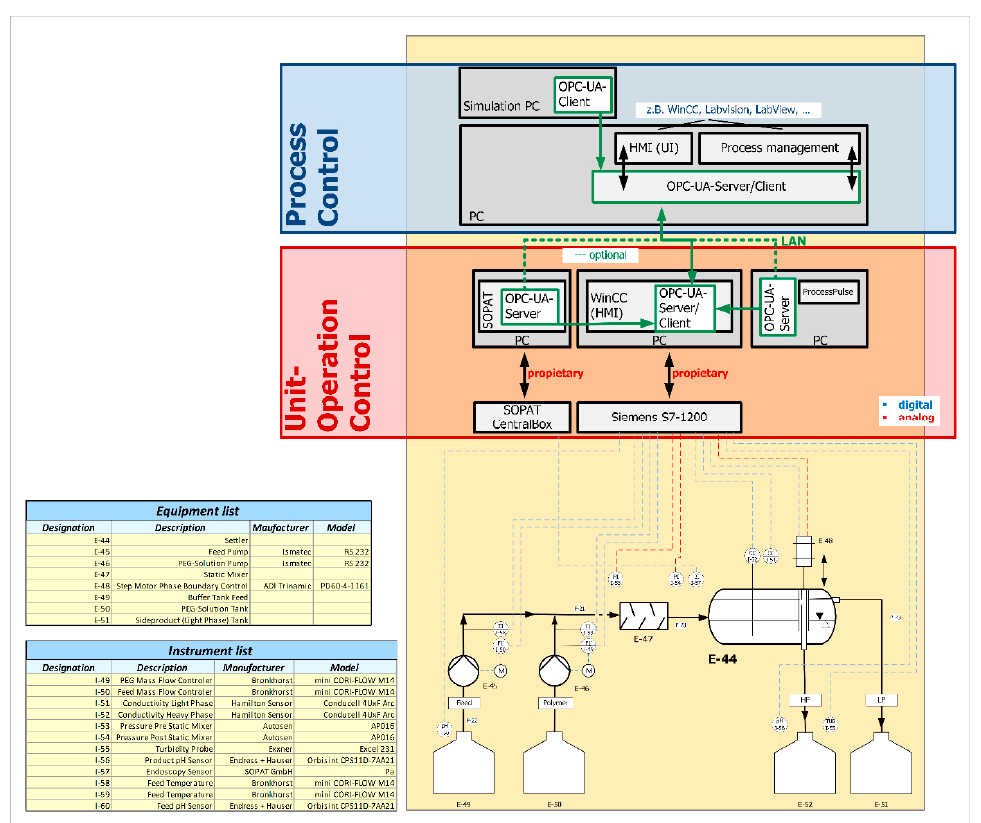
Figure 9. Process and instruments flow diagram of the separator and control level.